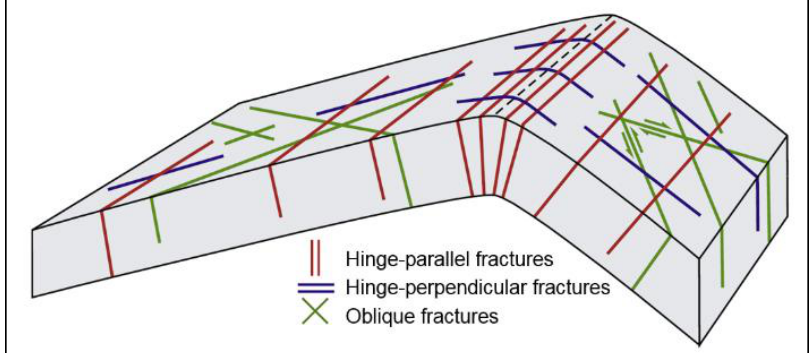
Figure 5—Observed fracture sets shown in Price's classification of fracture sets typical for asymmetric anticlines.